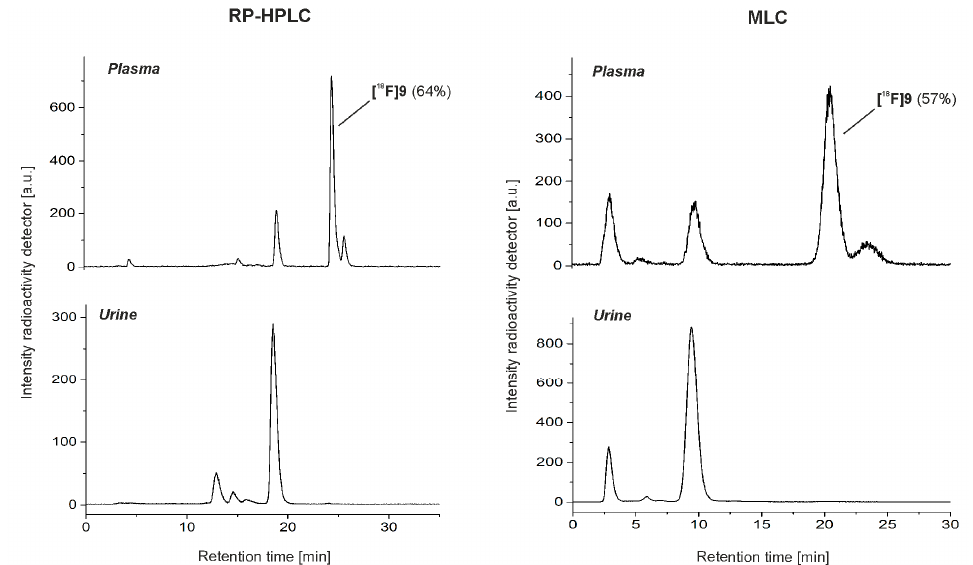
Figure 2. Exemplary RP-HPLC (left) and MLC (right) radio-chromatograms of mouse plasma and urine samples at 30 min p.i. of [ 18 F]9 (conditions RP-HPLC: Reprosil-Pur C18-AQ, 250 × 4.6 mm, gradient with eluent mixture of ACN/20 mM aq. NH 4 OAc, 1.0 mL/min; conditions MLC: Reprosil-Pur C18-AQ, 250 × 4.6 mm, gradient with an eluent mixture of EtOH/100 mM aq. SDS/25 mM aq. (NH 4 ) 2 HPO 4 , 1.0 mL/min).